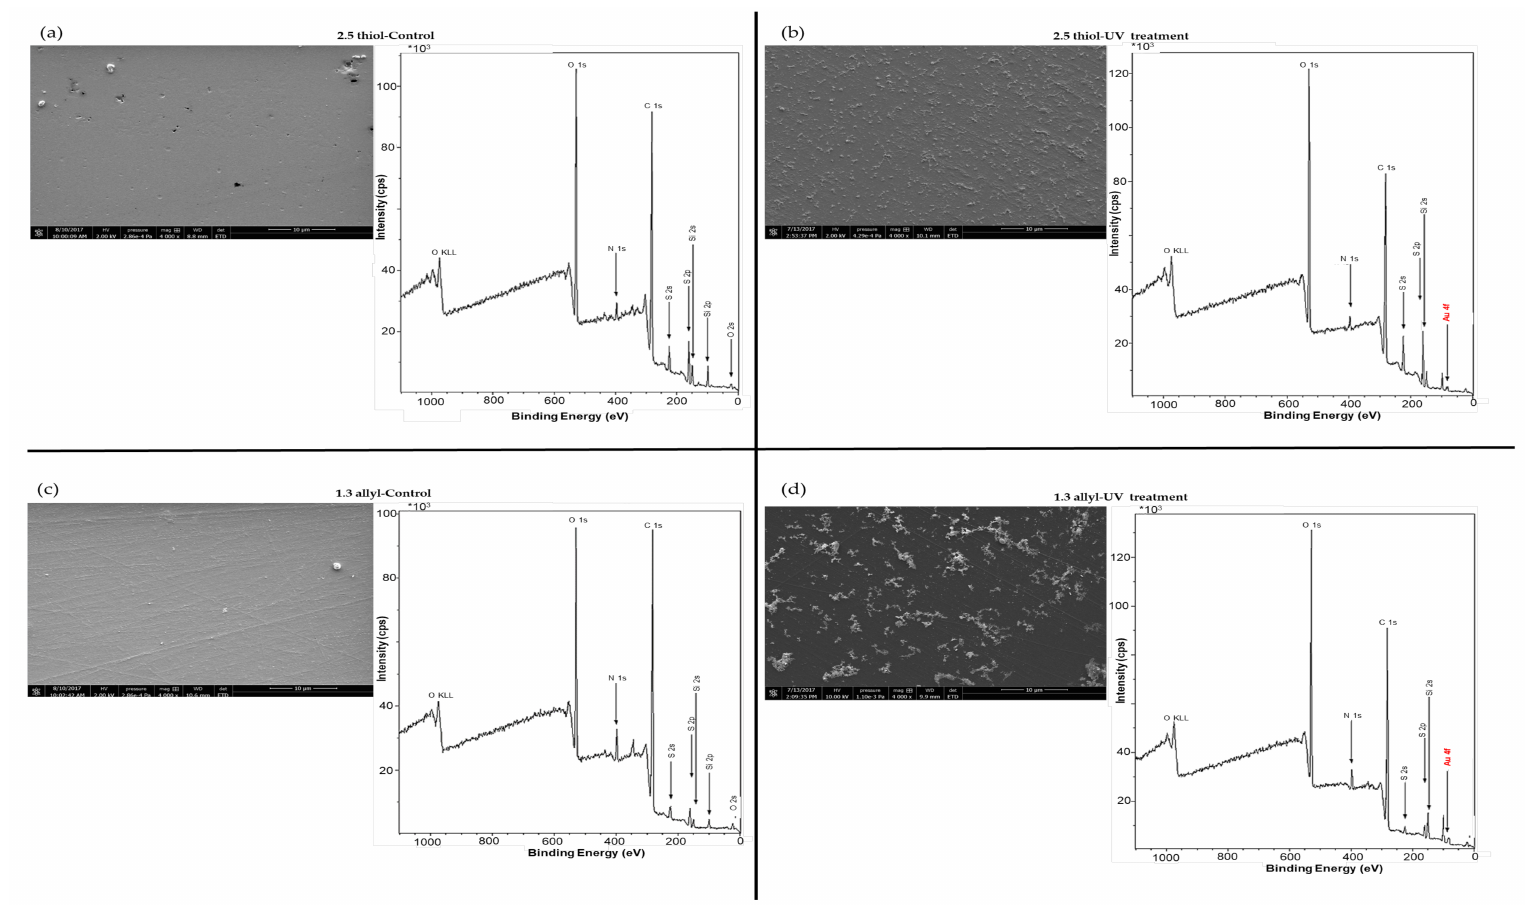
Figure 3. SEM micrography and XPS spectra of OSTE surfaces ( a , b ) 2.5 thiol and ( c , d ) 1.3 allyl) raw material for control ( a , c ) and after UV treatment ( b , d ). The plates were treated with the AuNP-1 solution. Plates were washed with ultra-pure water using ultrasound for 1 min before surface characterization (See experimental section for more details on experimental